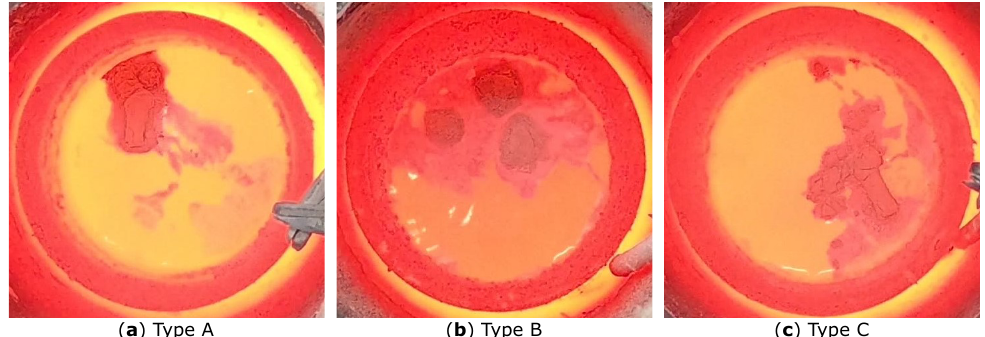
Figure 12. Selected images from the video recording of fines, selected from right after feeding to display the dispersion.